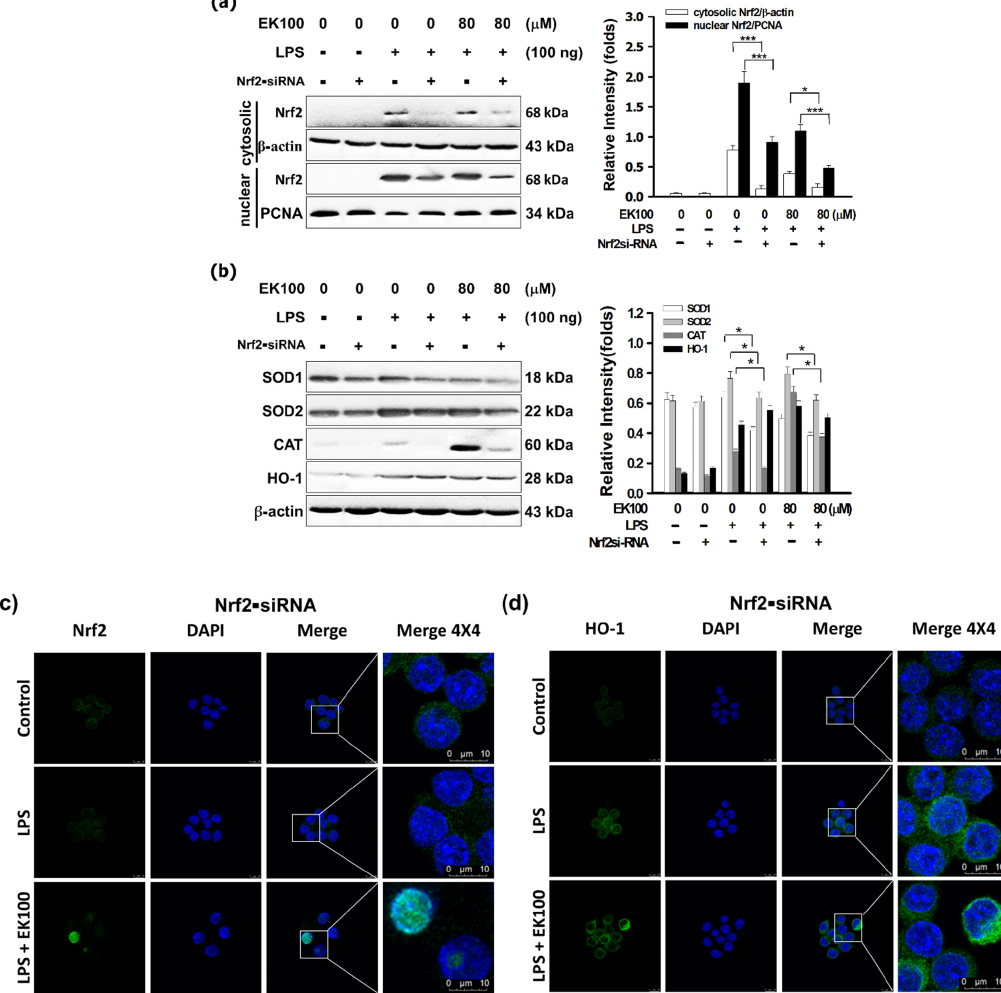
Figure 6. Nrf2 siRNA reversed EK100 activated the Nrf2/HO-1 pathway in LPS-stimulated cells. ( a ) Nrf2 siRNA or Nrf2-negative control siRNA was transfected into cells for 24 h and was collected. Cells were treated with 80 µM EK100 and 15 µM CLI-095 for 1 h before being stimulated with LPS for 6 h. The protein levels of Nrf2 in the cellular cytoplasm and cellular nucleus were analyzed by WB assay. ( b ) Nrf2 siRNA or Nrf2-negative control siRNA was transfected into cells for 24 h and was collected. Cells were treated with 80 µM EK100 and 15 µM CLI-095 for 1 h before being stimulated with LPS for 24 h. WB analyzed the protein expressions of HO-1, SOD1, SOD2, and CAT. ( c ) Nrf2 siRNA or Nrf2-negative control siRNA was transfected into cells for 24 h and was collected. Representative images showing the effect of 80 µM EK100 on Nrf2 protein expression were measured by IF staining in LPS-stimulated RAW 264.7 cells. ( d ) Nrf2 siRNA or Nrf2-negative control siRNA was transfected into cells for 24 h and was collected. Illustrative images of IF staining showed the effect of 80 µM EK100 on HO-1 protein expression in LPS-stimulated RAW 264.7 cells. All the experiments were des- ignated in Materials and Methods. All results were expressed as folds mean ± SEM compared with β -actin in the cytoplasm or PCNA in the cellular nucleus of three independent experiments ( n = 3). # p < 0.05 compared with the control group, * p < 0.05 and *** p < 0.001 compared with the LPS alone group or no Nrf2 siRNA treated group.